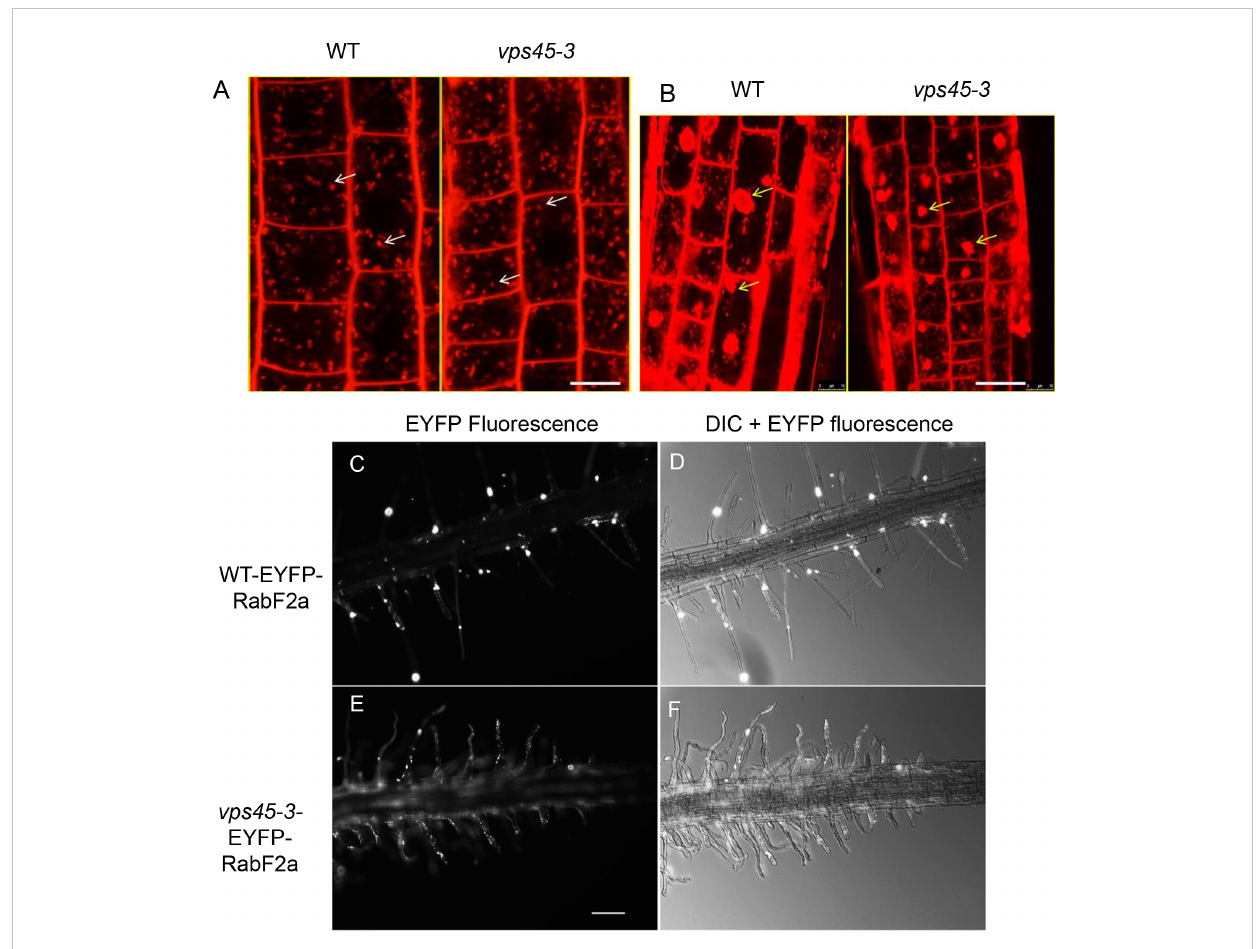
FIGURE 5 vps45-3 mutants have unaltered bulk endocytosis and transport of membrane cargo from the plasma membrane to BFA bodies. (A) 4-day old seedling roots were treated with 4 m M FM4-64 in liquid 0.5x MS medium and imaged by confocal microscopy after 2 min of treatment. White arrows indicate early endosomes/TGN. (B) Root cells were treated with 35 m m BFA for 1 h, followed by a 10 min incubation with 4 m M FM4-64, showing arrival of FM4-64 at BFA bodies. Yellow arrows indicate BFA bodies. Scale bar = 10 m m. (C – F) Root hairs of 5-day-old seedlings expressing the early endocytic compartment marker EYFP-RabF2a were imaged using a Zeiss Upright microscope with 40X objective lens either with transmitted light or with epi fl uorescence illumination and appropriate EYFP fi lters. Scale bar = 500 m